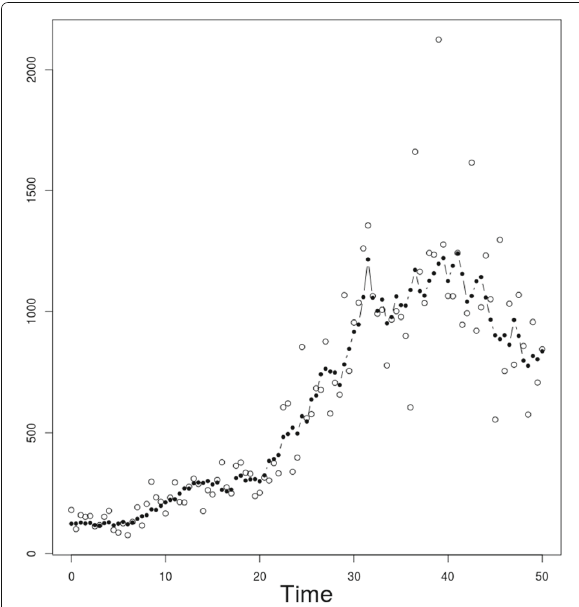
Fig. 8 Log-growth model - observations. Process X solution to the SDE (balls) and observations Y (circles) at times t 0 = 0, ... , t 100 = 50